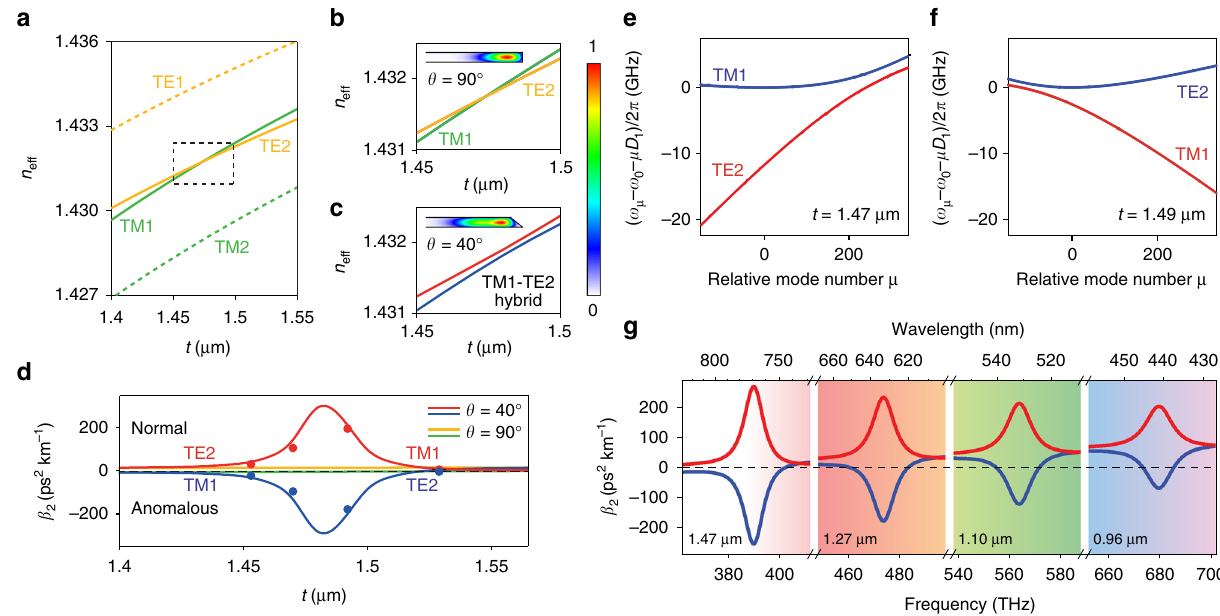
Fig. 3 Dispersion engineering and solition generation at 778 nm. a Calculated effective indices n eff for TE1, TE2, TM1, and TM2 modes at 778 nm plotted vs. thickness for a silica resonator with re fl ection symmetry (i.e., θ = 90°). The TM1 and TE2 modes cross each other without hybridization. b Zoom-in of the dashed box in a . c As in b but for a resonator with θ = 40°. An avoided crossing of TM1 and TE2 occurs due to mode hybridization. Insets of b , c show simulated mode pro fi les (normalized electric fi eld) in resonators with θ = 90° and θ = 40°, respectively. The color bar is shown to the right. d Calculated GVD of the two modes. For the θ = 40° case, hybridization causes a transition in the dispersion around the thickness 1.48 µ m. The points are the measured dispersion values. e , f Measured relative mode frequencies of the TM1 and TE2 mode families vs. relative mode number μ for devices with t = 1.47 µ m and t = 1.49 µ m. g Calculated total second-order dispersion vs. frequency (below) and wavelength (above) at four different oxide thicknesses (number in lower left of each panel). Red and blue curves correspond to the two hybridized mode families. Anomalous dispersion is negative and shifts progressively to bluer wavelengths as thickness decreases. Background color gives the approximate corresponding color